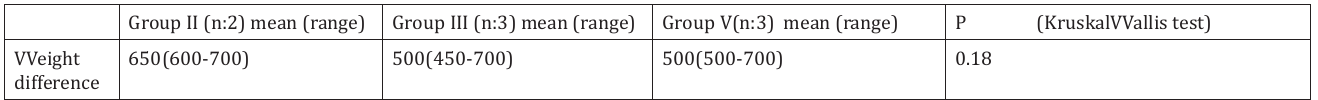
Comparison of weight differences of the animals during the experimental period of 24 weeks.